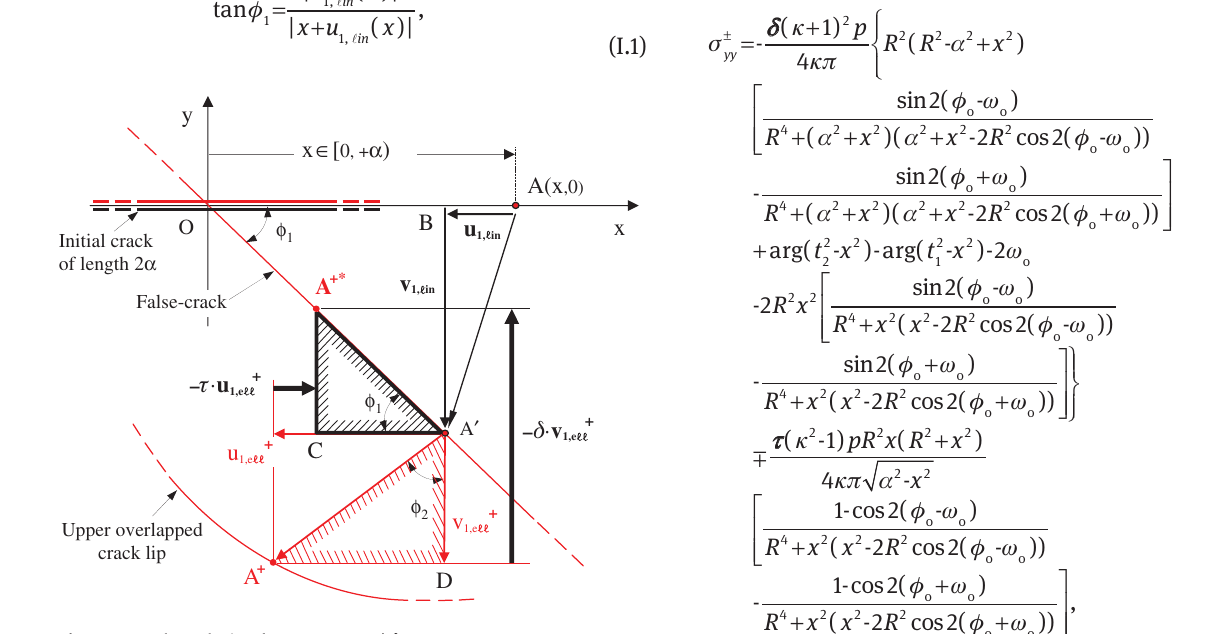
Figure A1 The relation between τ and δ